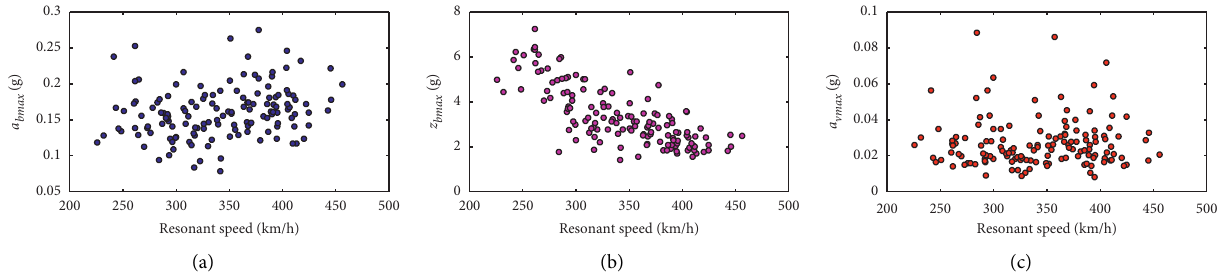
Figure 13: Maximum dynamic responses versus random train-induced resonant speed: (a) bridge midpoint accelerations; (b) bridge midpoint displacements; (c) car body accelerations.